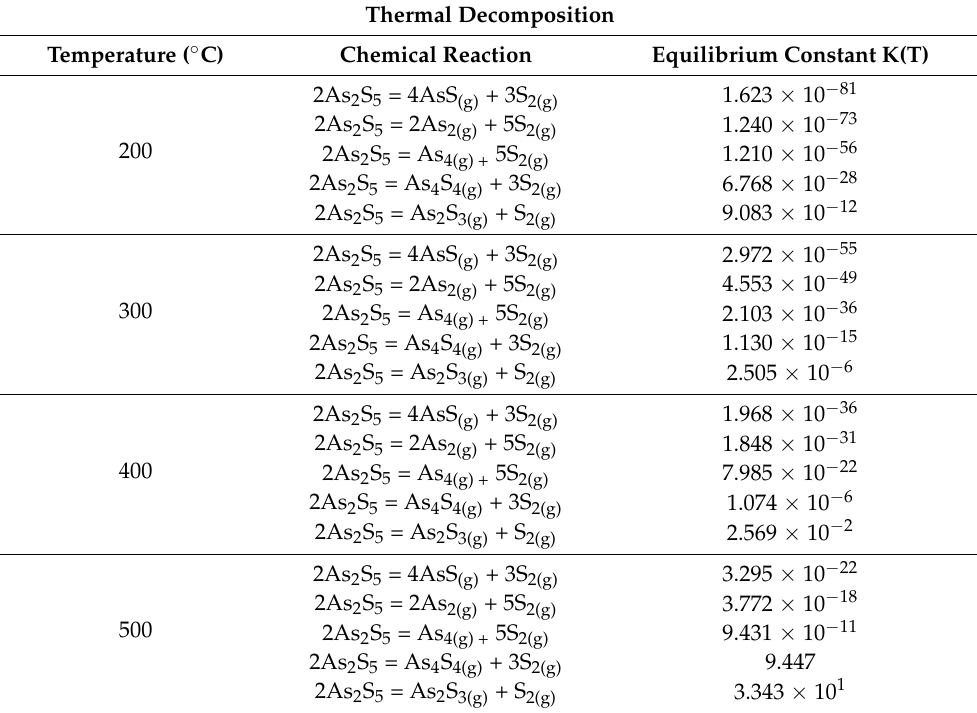
Table 4. Equilibrium constant for possible reaction mechanisms during thermal decomposition of As 2 S 5